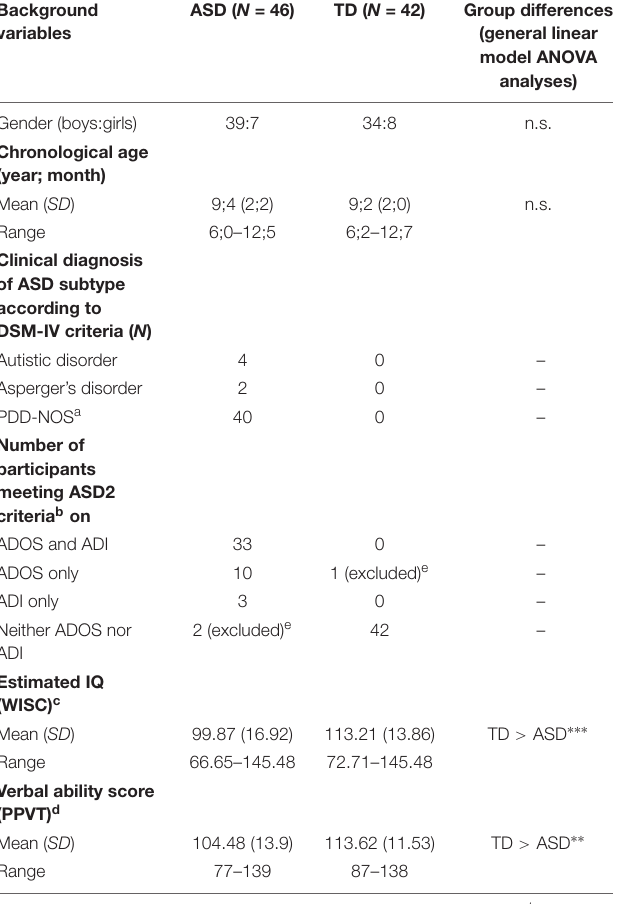
TABLE 1 | Description of the participants with autism spectrum disorder (ASD) and the typically developing (TD) participants in this study. Background variables